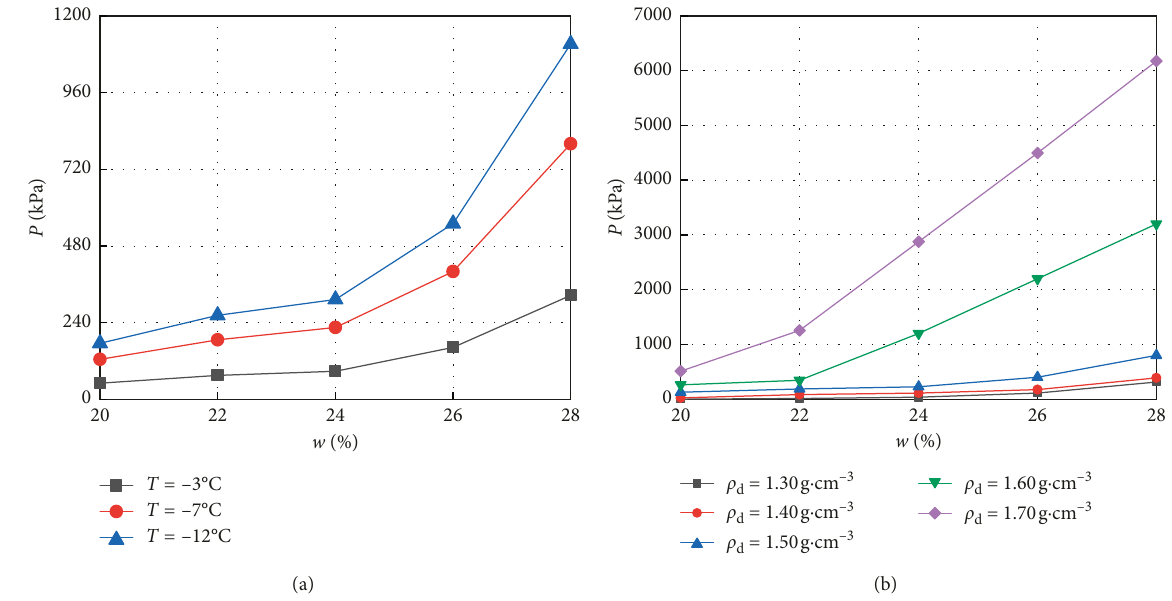
Figure 3: Relationship between water content and frost-heave force. (a) ρ